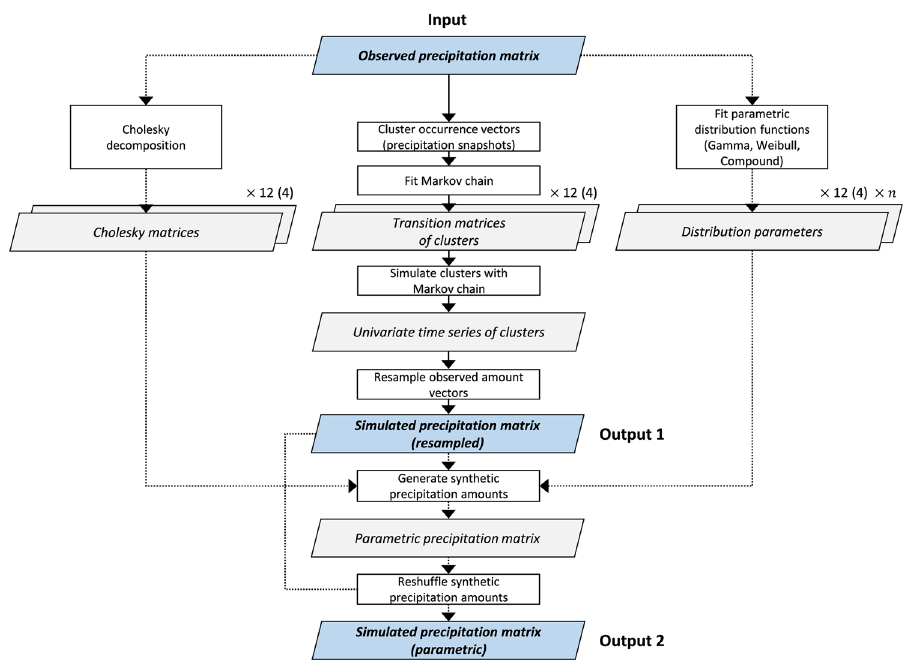
Figure 6. Schematic flow diagram of the TripleM precipitation generator. TripleM can be used as a bootstrap model (Output 1) and a parametric precipitation model (Output 2). Parallelograms represent time series or variables, boxes represent methods. Blue parallelograms represent input and output data. Cholesky matrices and transition matrices are either derived monthly (12) or seasonally (4). The parametric distribution parameters are either derived monthly (12) or seasonally (4) for the number of gauges simulated